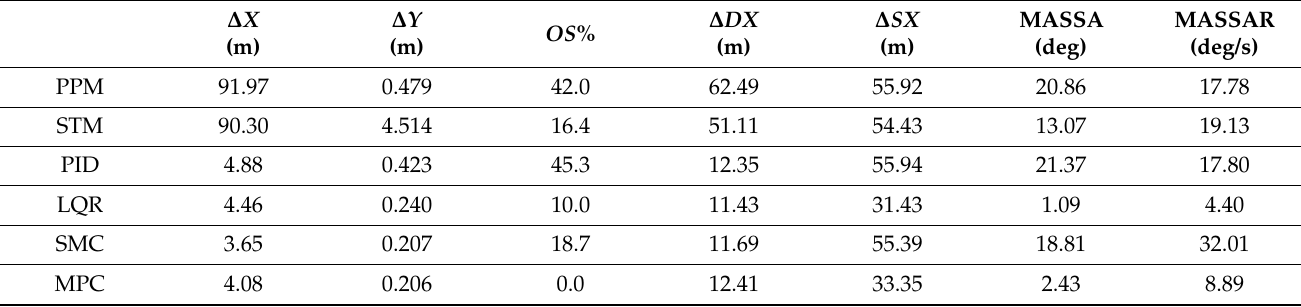
Table 5. Summary of simulation results of each controller for 4WS vehicle in the second set of